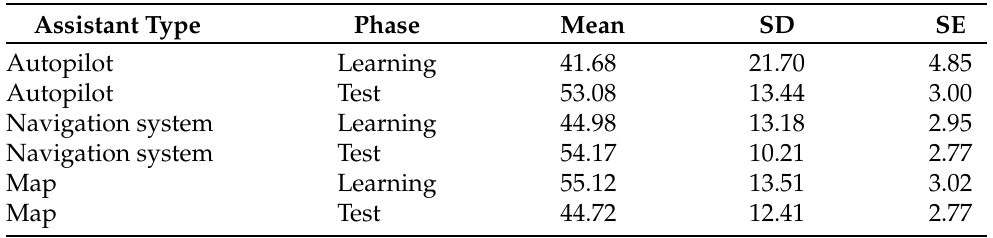
Table 2. Descriptive statistics for NASA-TLX score by assistant type and driving phase: mean, standard deviation, and standard